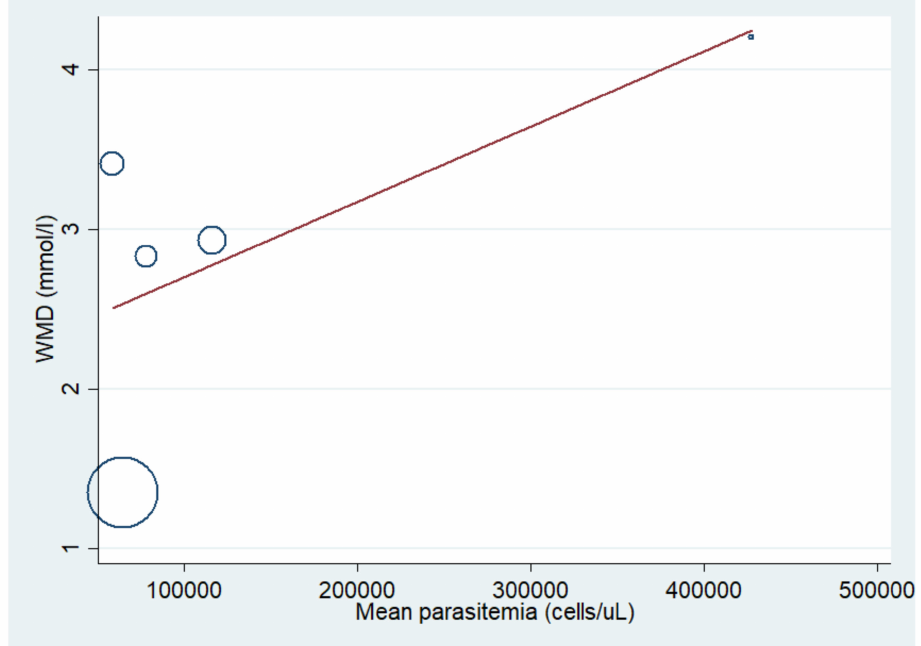
Figure 12. Lactate levels in patients with severe malaria who died and those who survived using mean parasitemia as a co-variate. Circles and dots show the WMD of individual studies. Abbreviations: WMD, weighted mean difference; CI, confidence